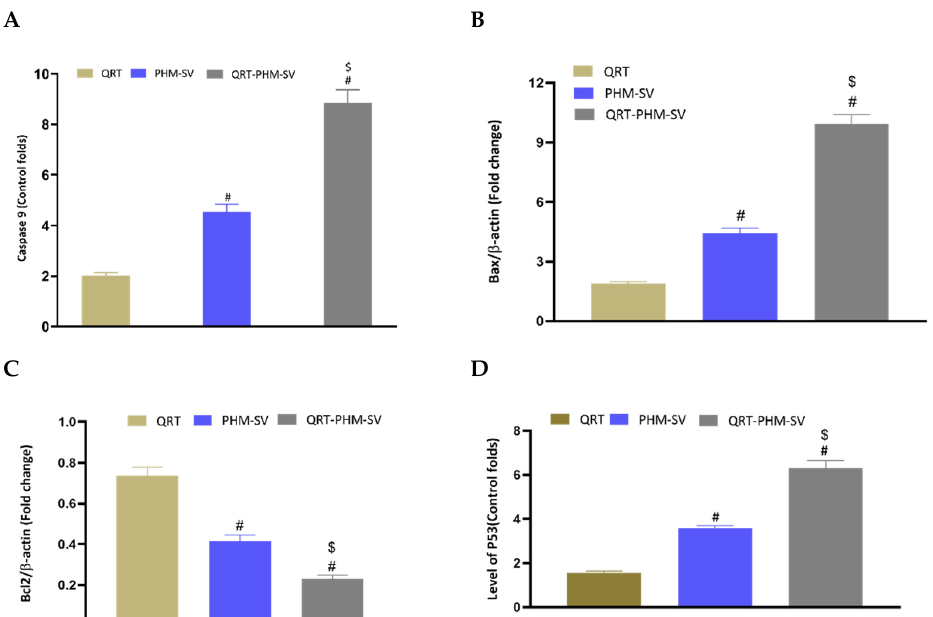
Figure 10. Effect of the QRT-PHM-SV formula on the expression of ( A ): caspase-9, ( B ): Bax, ( C ): Bcl-2, and ( D ): p53. Data are presented as Mean ± SD (n = 3); # significantly different from QRT at p < 0.05; $ significantly different from plain formula (PHM-SV) at p < 0.05.